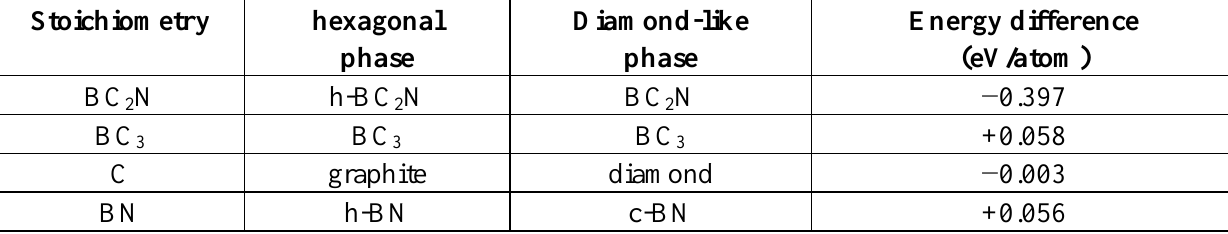
Table 2. Local density approximation (LDA) calculated relative energies of precursor graphitic and super-hard diamond-like structures. A positive value indicates that the precursor phase is higher in energy that the diamond-like phase. The estimated calculational uncertainty is 10